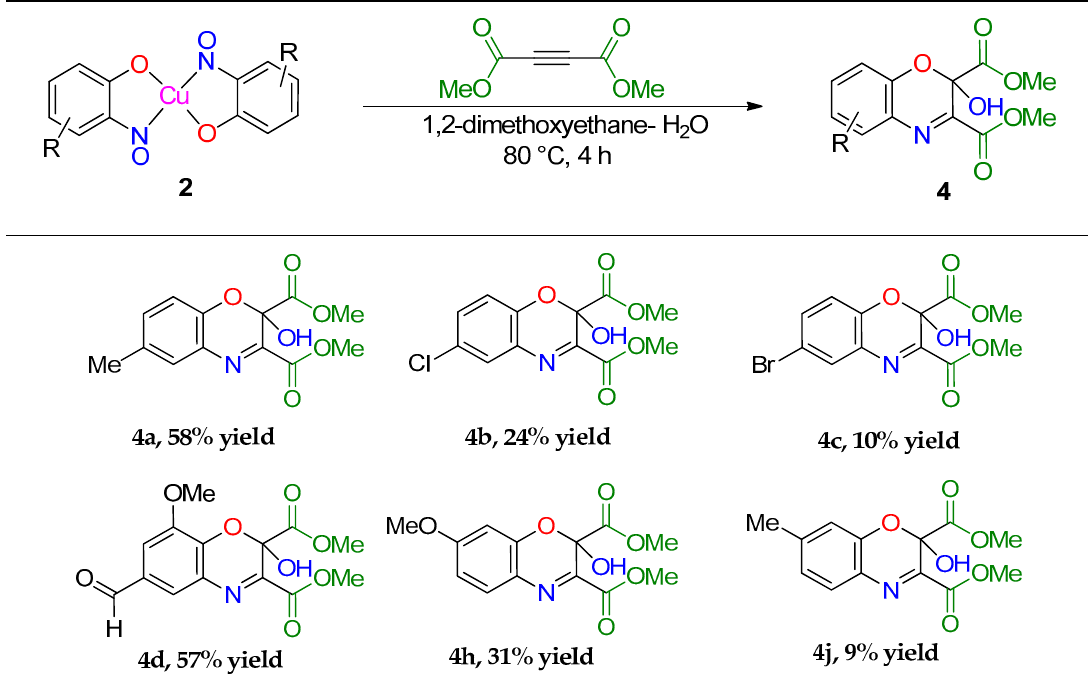
Table 4. 2,4-Cycloaddition reactions of copper-nitrosophenolato compounds to unique bicyclic structures.